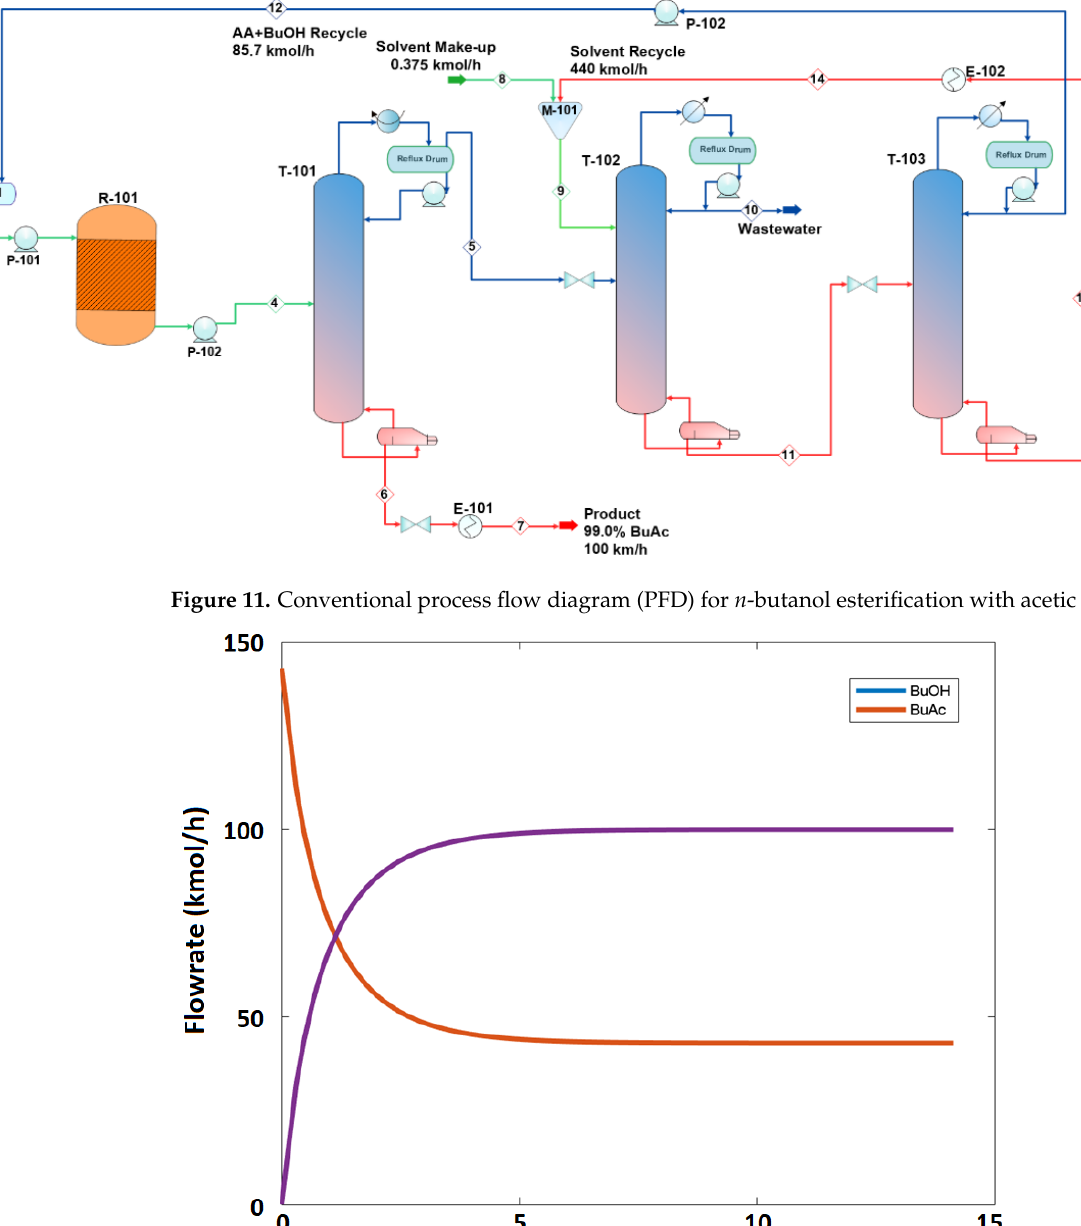
Figure 12. Components flowrates as a function of reactor length using the kinetic model.